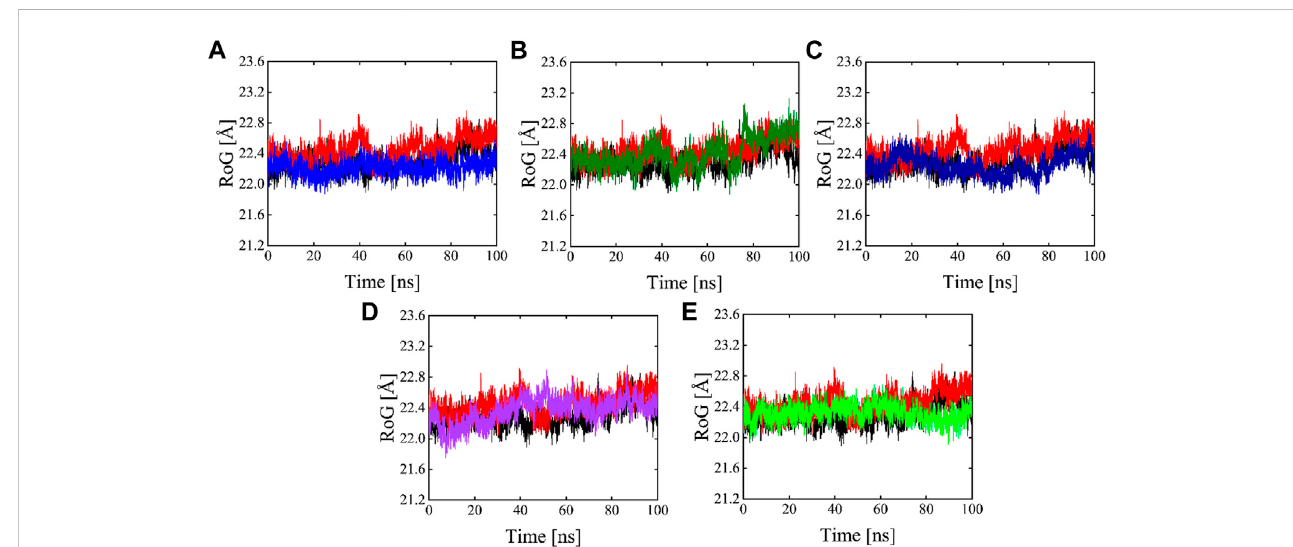
FIGURE 10 Rg plots of Apo (Black), red (reference), and Compound 1-5 are labeled different colors as (A – E) Respectively.